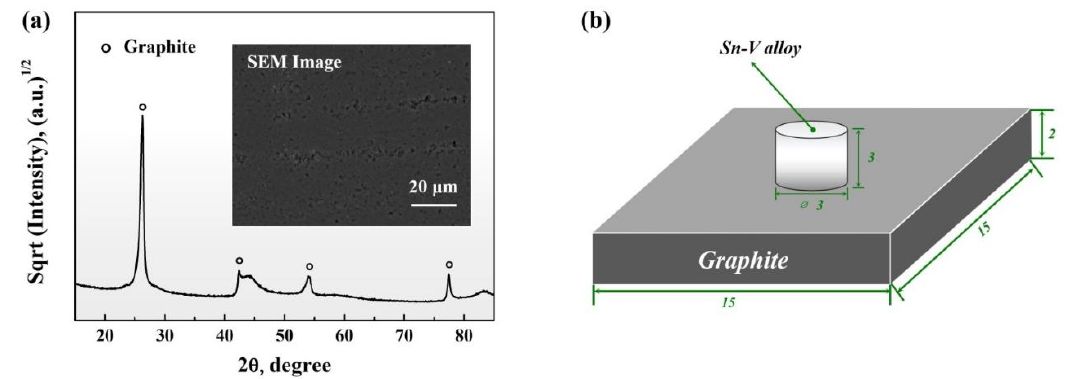
Figure 1. ( a ) XRD pattern and SEM image of prepared porous graphite substrates; ( b ) Schematic illustration of sample assembling.